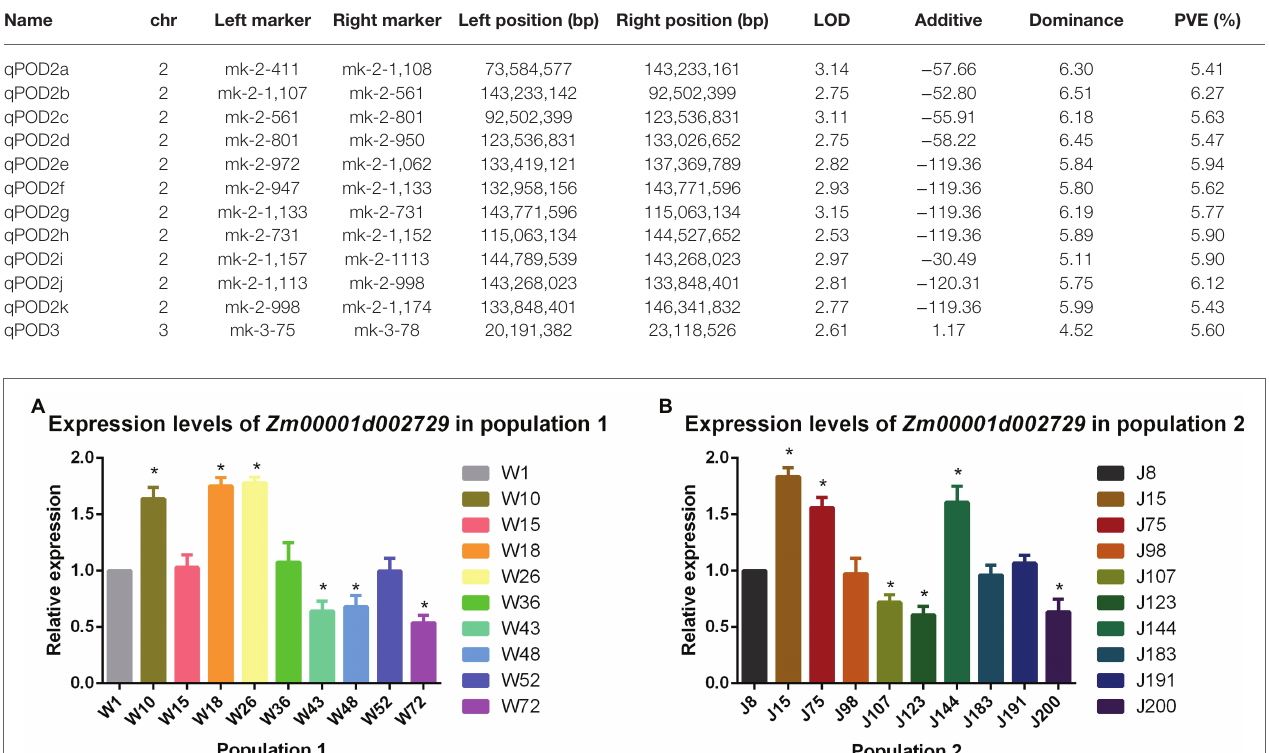
FIGURE 6 | (A) Relative expression levels of Zm00001d002729 in population 1 and (B) population 2.